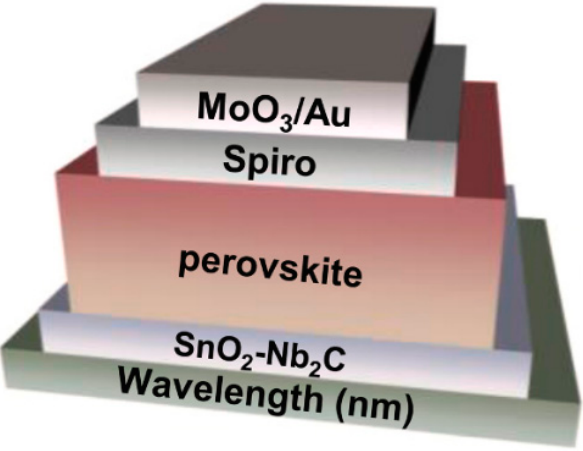
Figure 2. Schematic of the PSCs structure. Reprinted with permission from Ref. [24]. 2021, Else- vier.